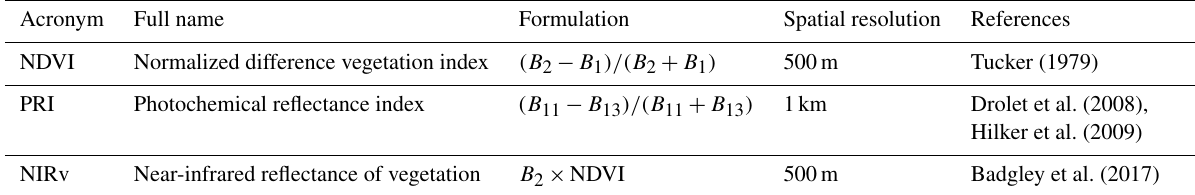
Table 1. MODIS Terra and Aqua vegetation index computations. B 2 (841–876nm) denotes the surface spectral reflectance at band 2, B 1 (620–670nm) denotes the surface spectral reflectance at band 1, B 11 (526–536nm) represents the surface spectral reflectance at band 11, and B 13 (662–672nm) represents the surface spectral reflectance at band